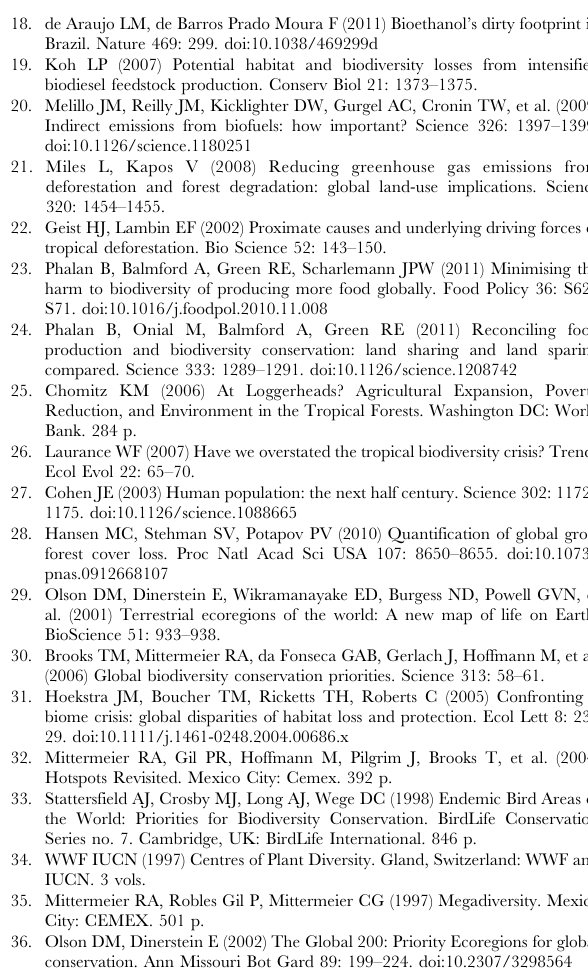
Figure S1 Overlap between cultivation potential and protected areas for (A) Neotropical countries, (B) tropical Africa and (C) tropical Asia/Australia. Map of cultivation potential in relation to cropland is as for Figure 5. Database on Protected Areas (WDPA). [The WDPA is a joint